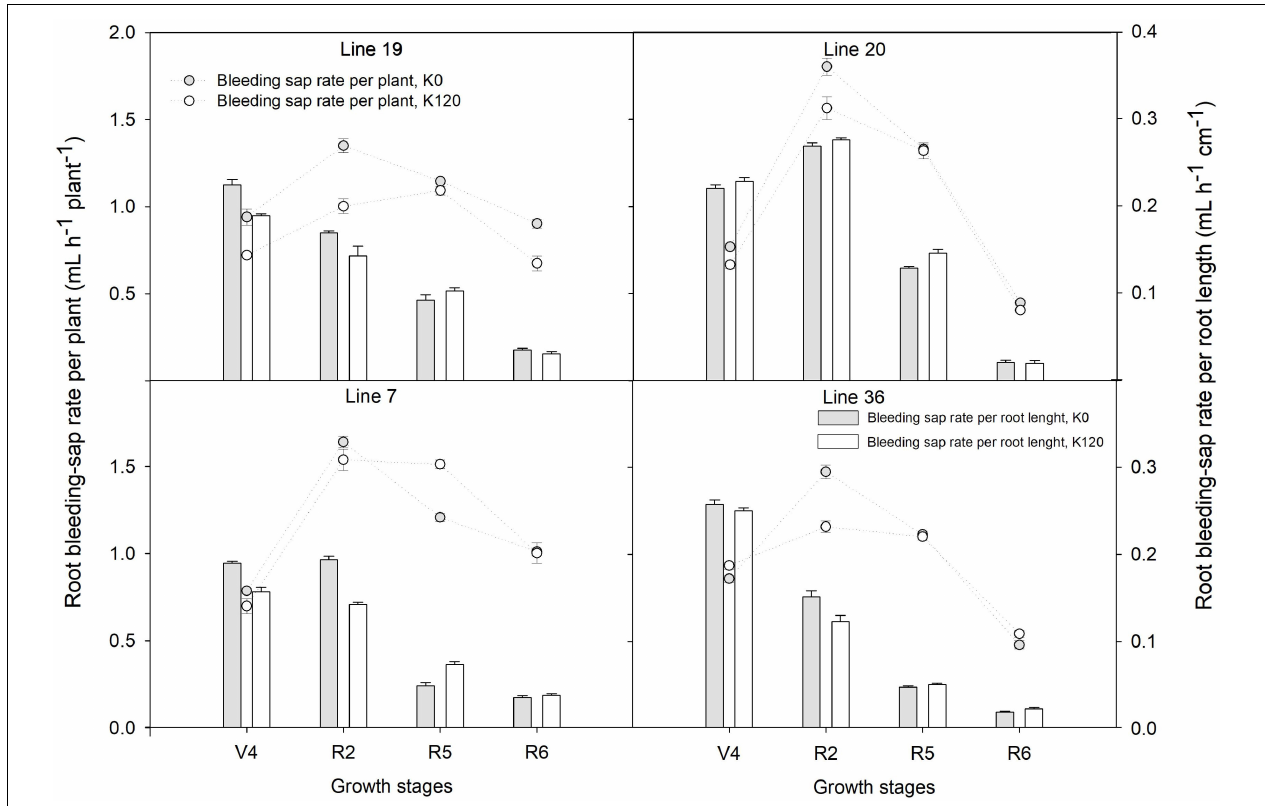
FIGURE 1 | Root bleeding-sap of distinct potassium (K) efficiency genotypes under low K application in a pot experiment. Values are means of three replicates ±